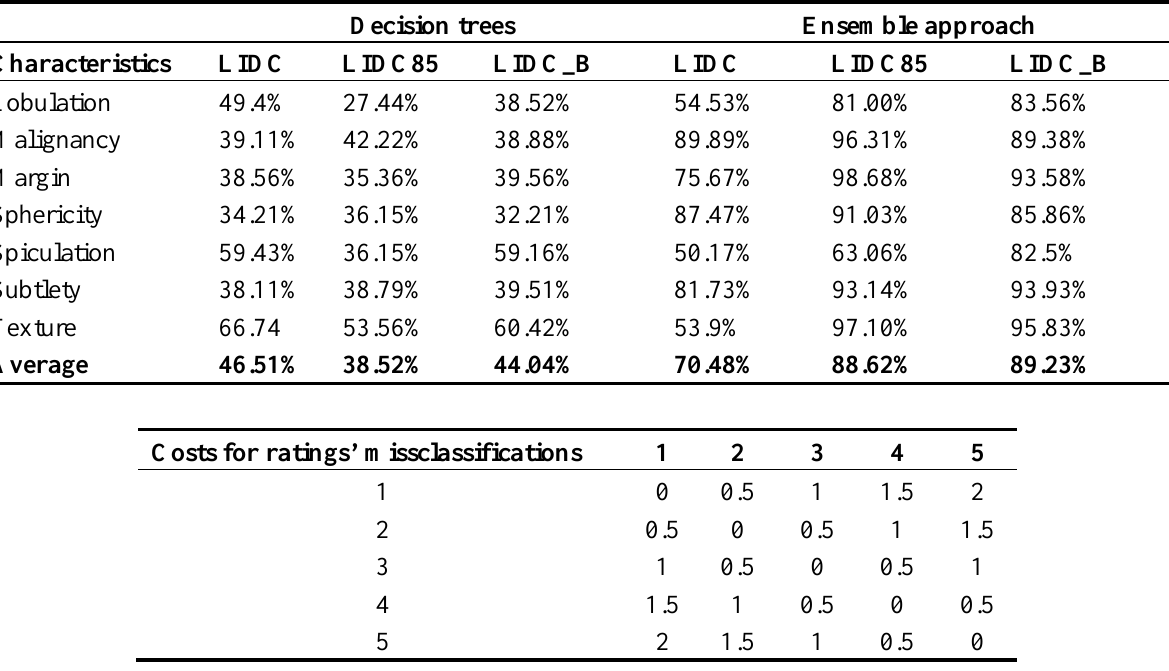
Table 7. Classification accuracies of decision trees and an ensemble of decision trees on all datasets.